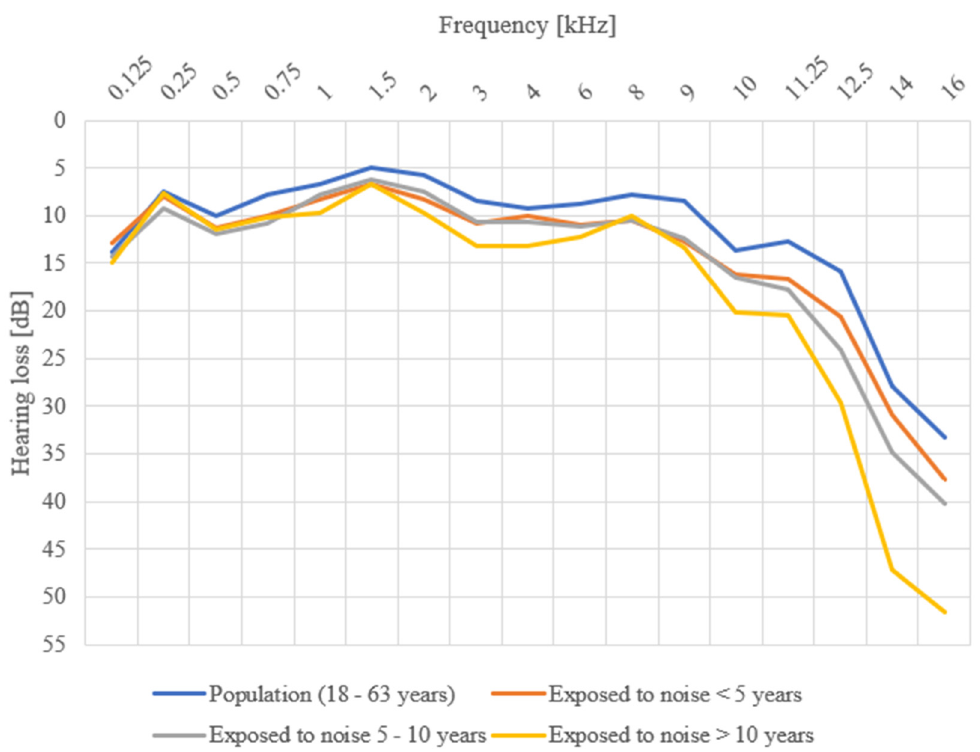
Figure 2. Average hearing thresholds of women exposed and unexposed to workplace noise, depending on the length of work-related exposure to noise.